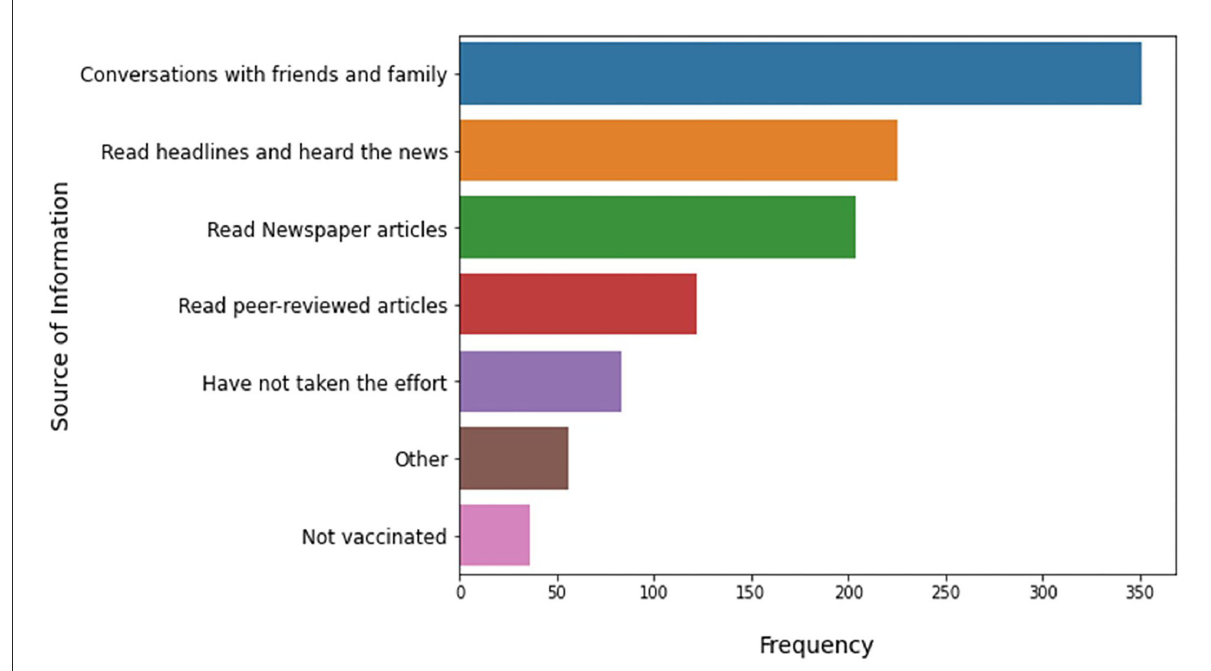
FIGURE5 Sources of information. The bar graphs illustrate the various commonly used media through which respondents got their information about topics such as vaccines, vaccine development, and diseases. The list of sources was predefined in the